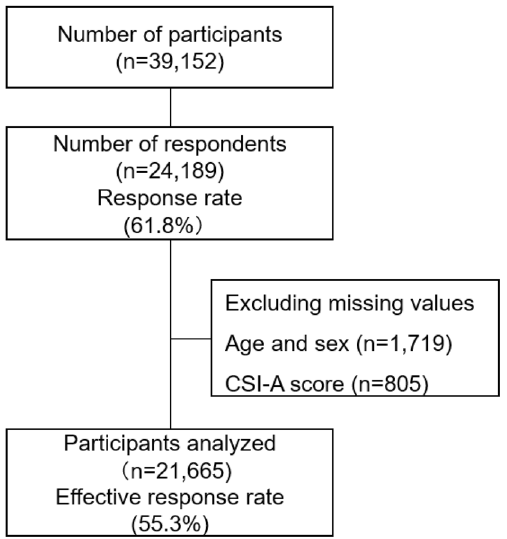
Figure 1. Chart of the epidemiological survey. CSI Central sensitization